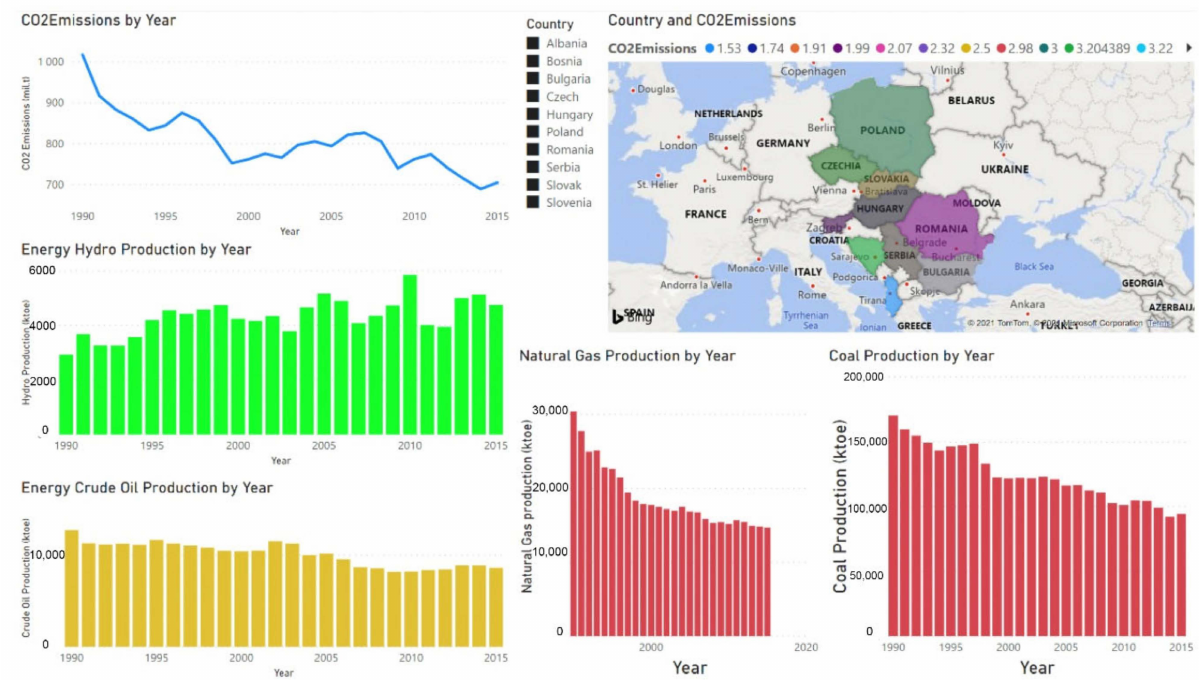
Figure 4. CO 2 emissions and type of energy for the country set